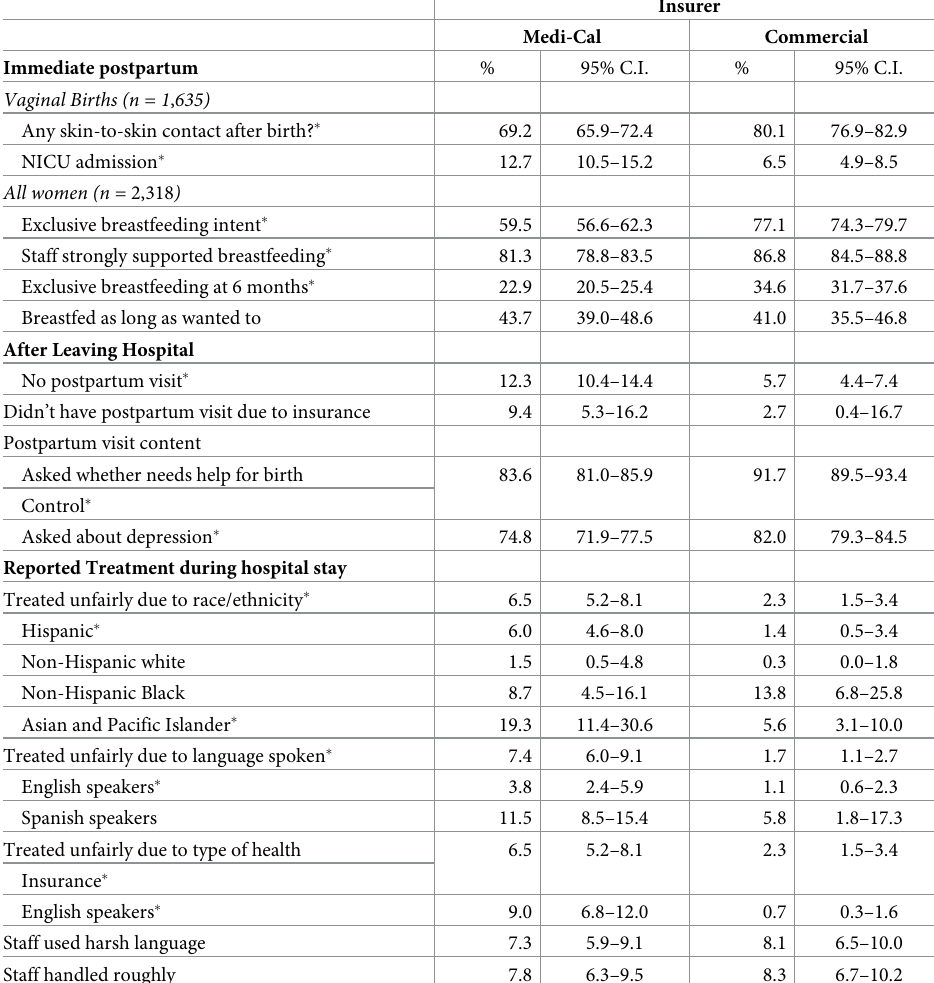
Table 3. Prevalence of postpartum experiences and perceived treatment, by